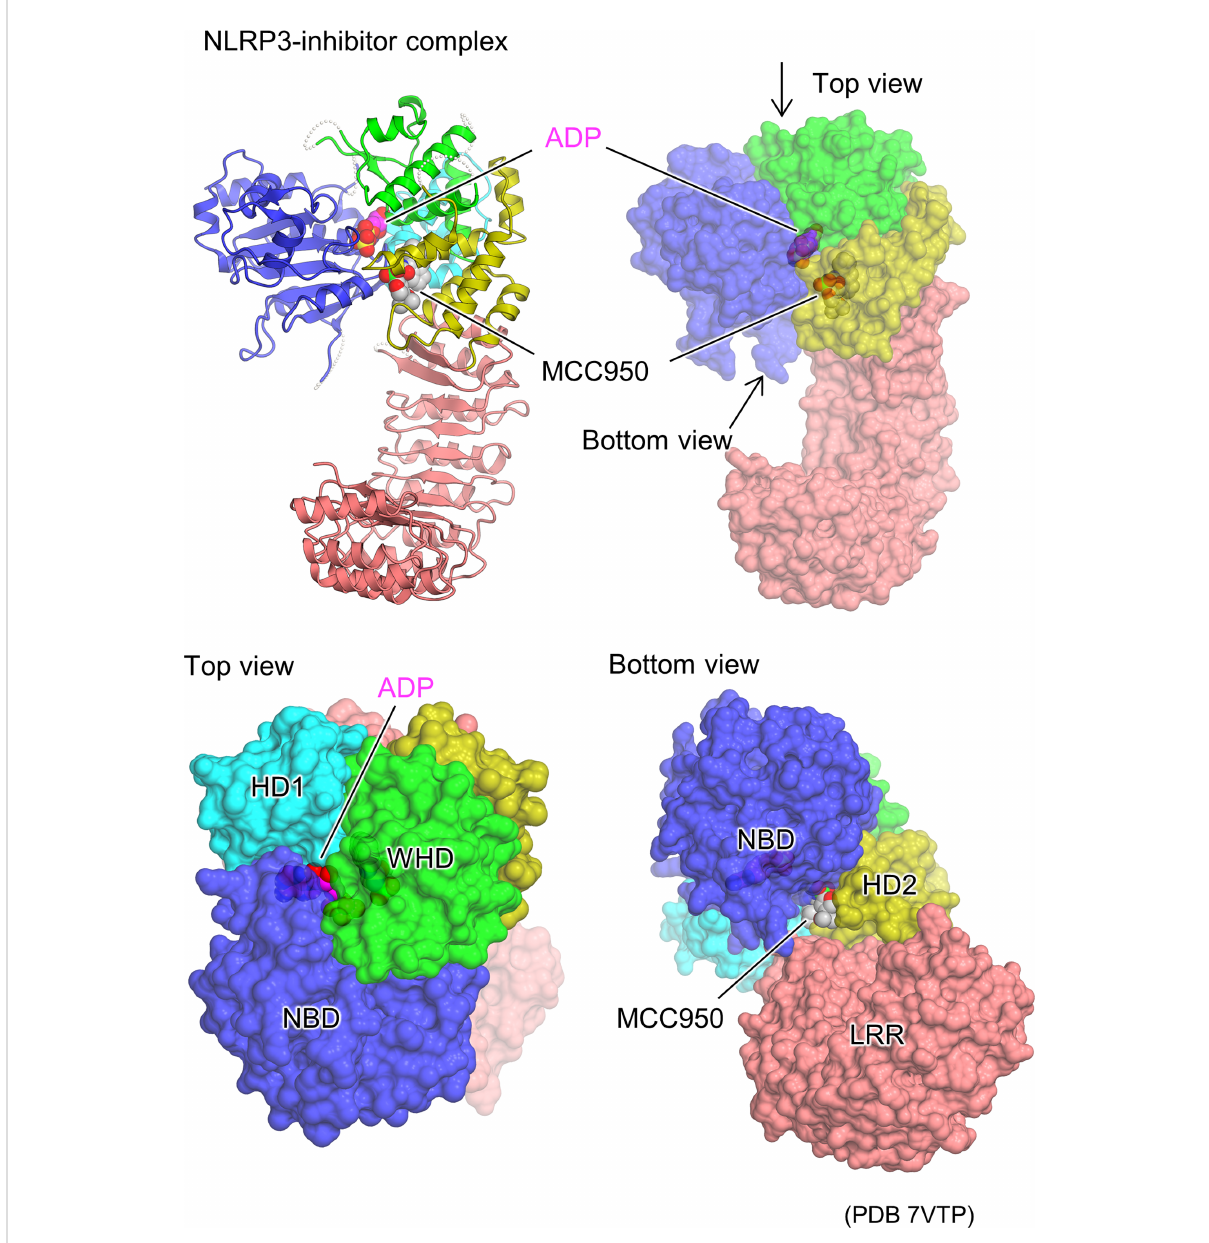
FIGURE 4 Structural basis of NLRP3 inhibitor binding. Protomer structure of the human NLRP3 (PYD deleted) hexamer (PDB 7VTP) (23) with bound molecules of the ADP and NLRP3 inhibitor, MCC950, is illustrated as space fi lling representations. Ribbon representation (top left) and surface representations from three different views (top right, bottom left, and bottom right) are